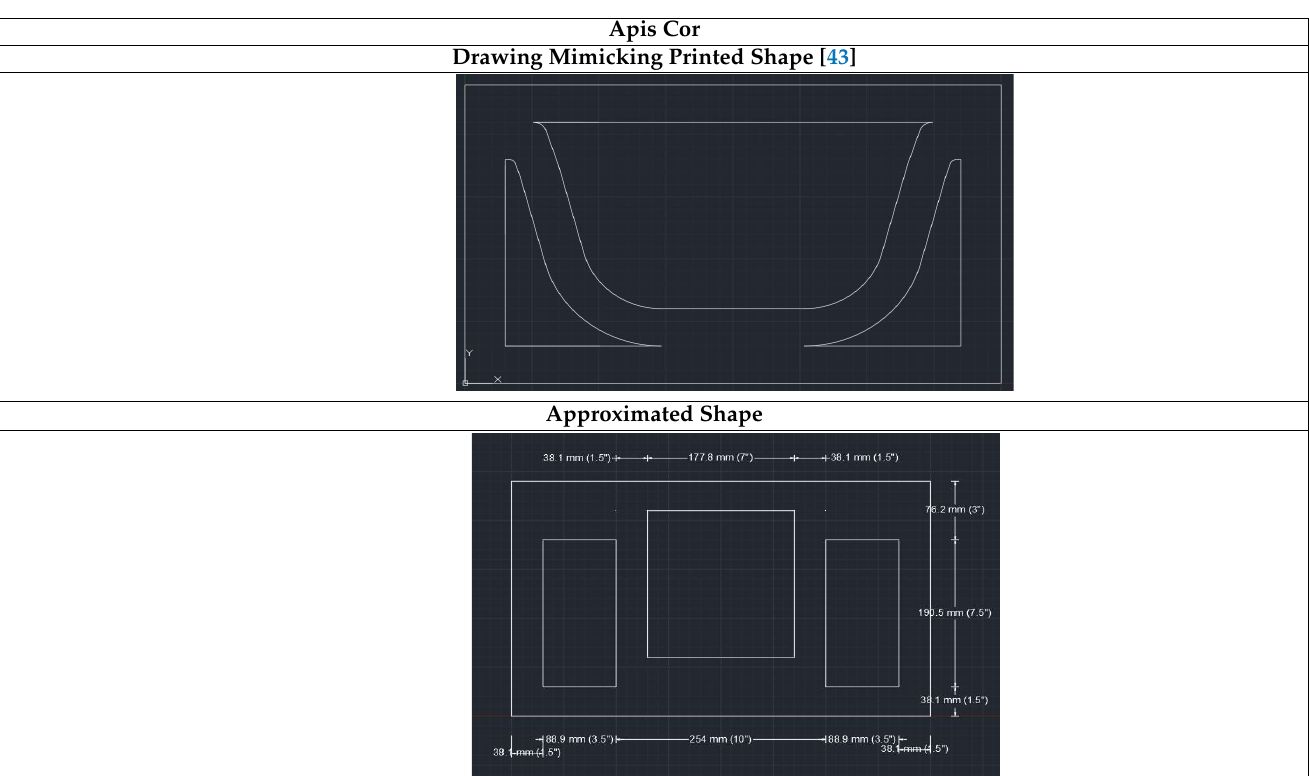
Table A6. Apis Cor wall calculations.